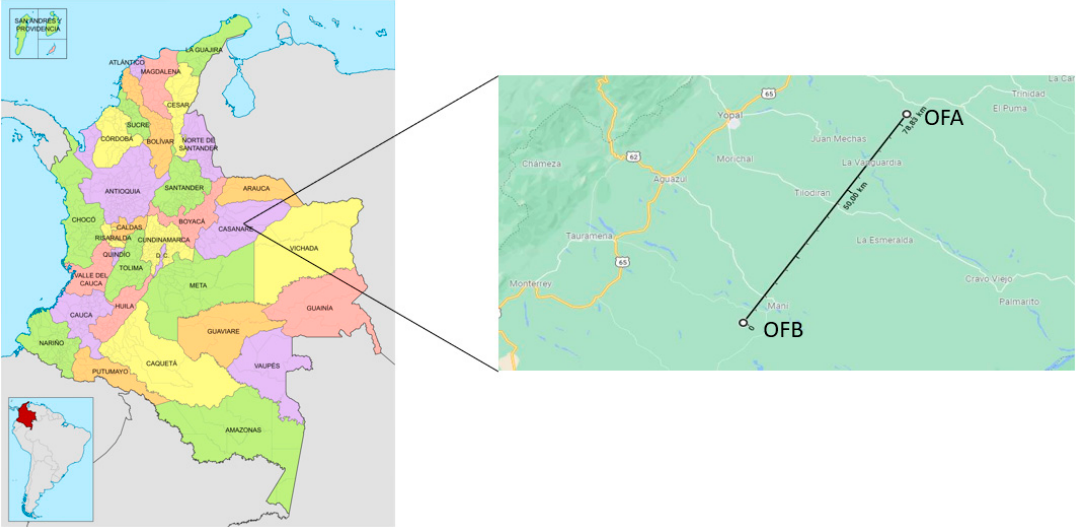
Figure 2. The geographic location in Colombia of the two subject oil fields in this study, OFA and OFB. The colors indicate the division of Colombia 32